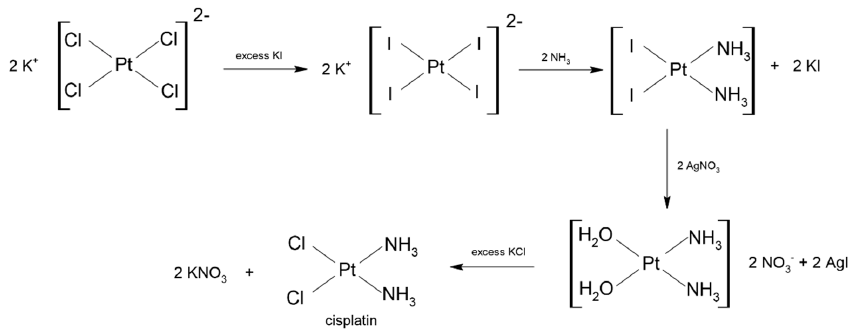
Figure 1. Scheme of cisplatin synthesis by Dhara’s method.